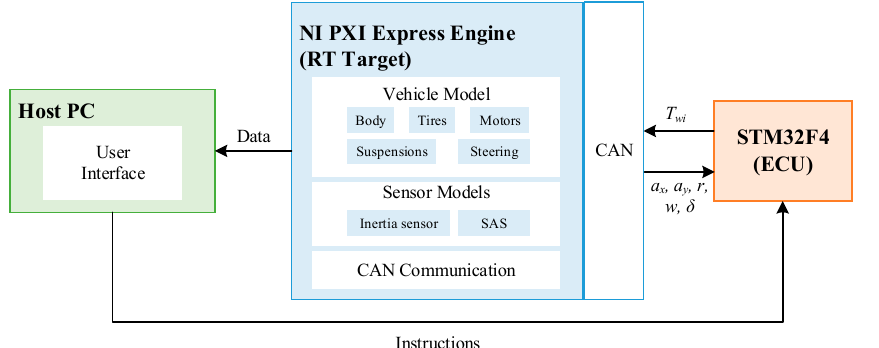
Figure 3. Structure of the HIL simulation system. ECU, electronic control unit; PC, personal computer. Table 3. Vehicle parameters.